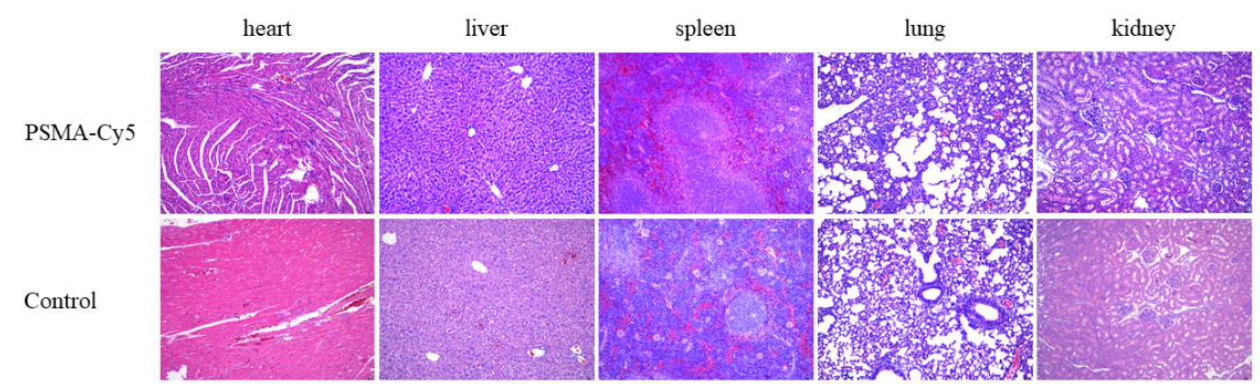
Figure 9. Histopathological analysis of the acute toxicity test. Organs include heart, liver, spleen, lungs, and kidneys. HE staining of mouse organ sections after high-dose injection of PSMA-Cy5 ( top ) and HE staining of mouse organ sections in the control group ( bottom ).